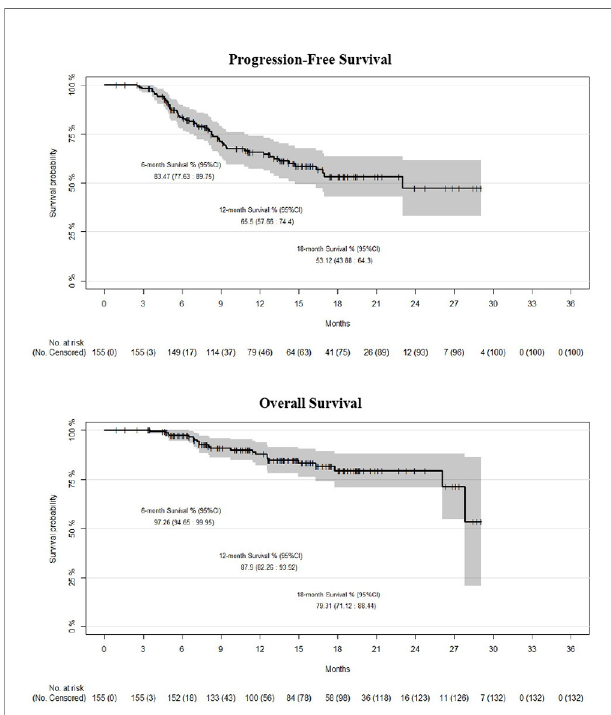
FIGURE 1 | Kaplan-Meier survival estimates (progression-free and overall survival) for the whole cohort (n =